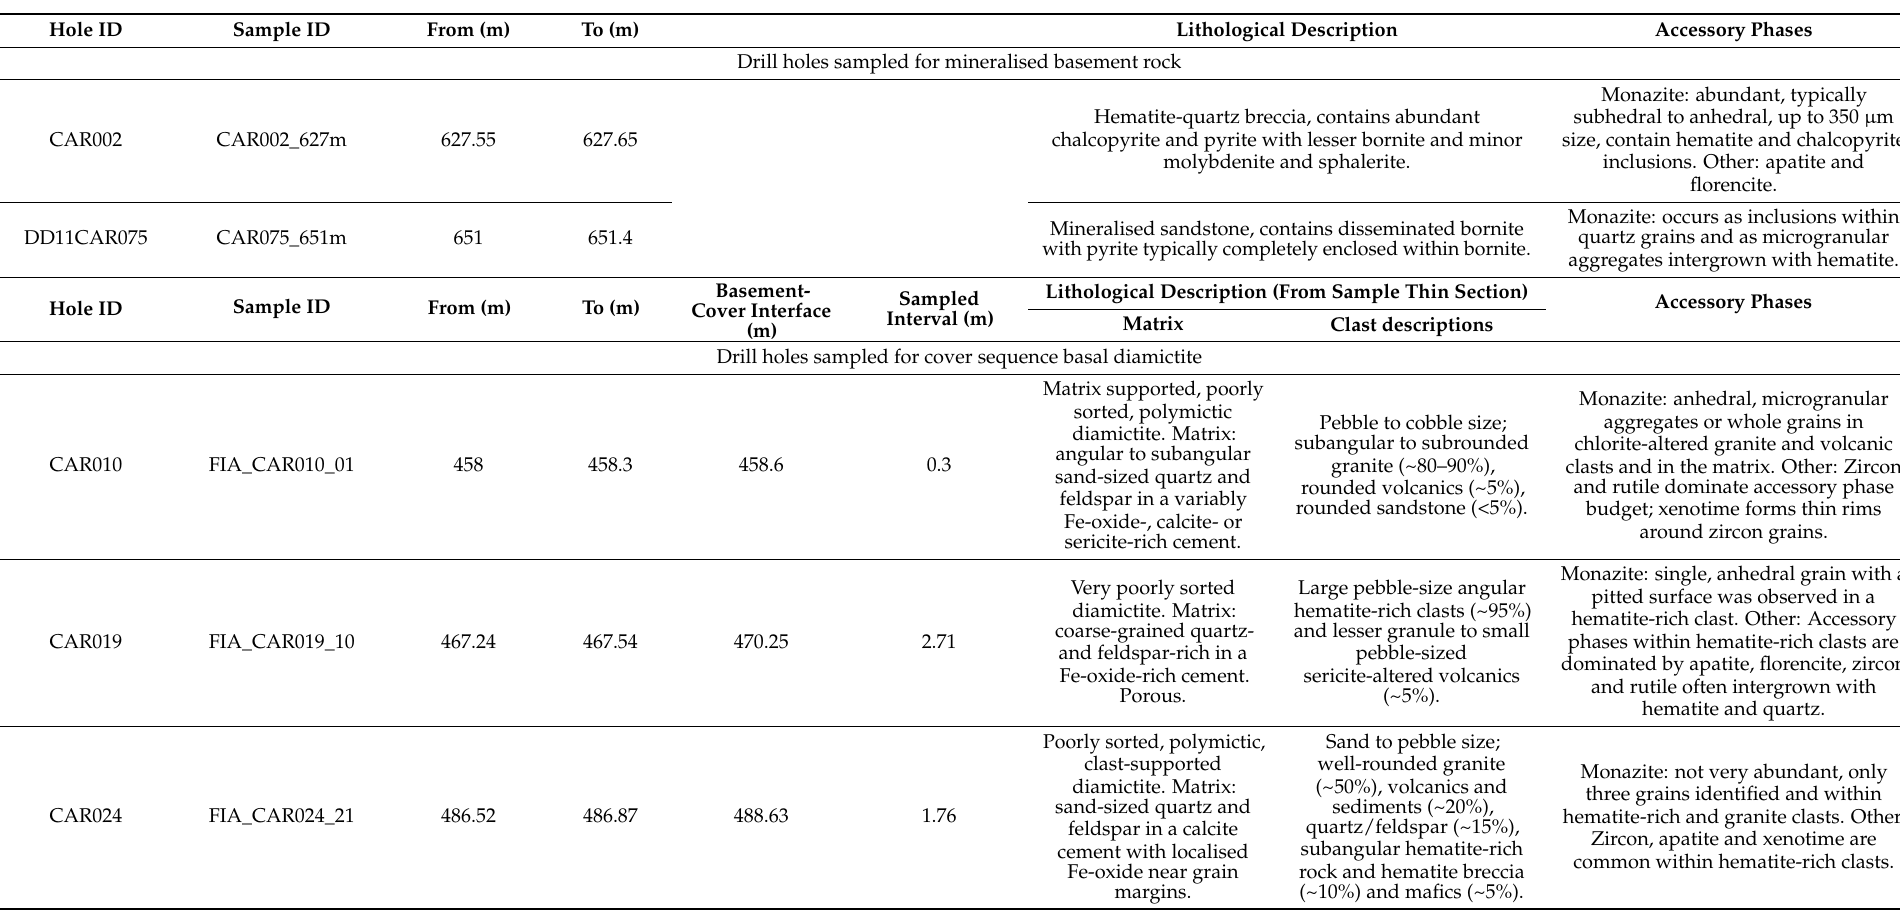
Table 1. Details for samples taken across the Carrapateena deposit and used in this study. Includes DH name, sample number, depth from, depth to, basement/cover sample, basic mineralogical description, clast types for the conglomerate